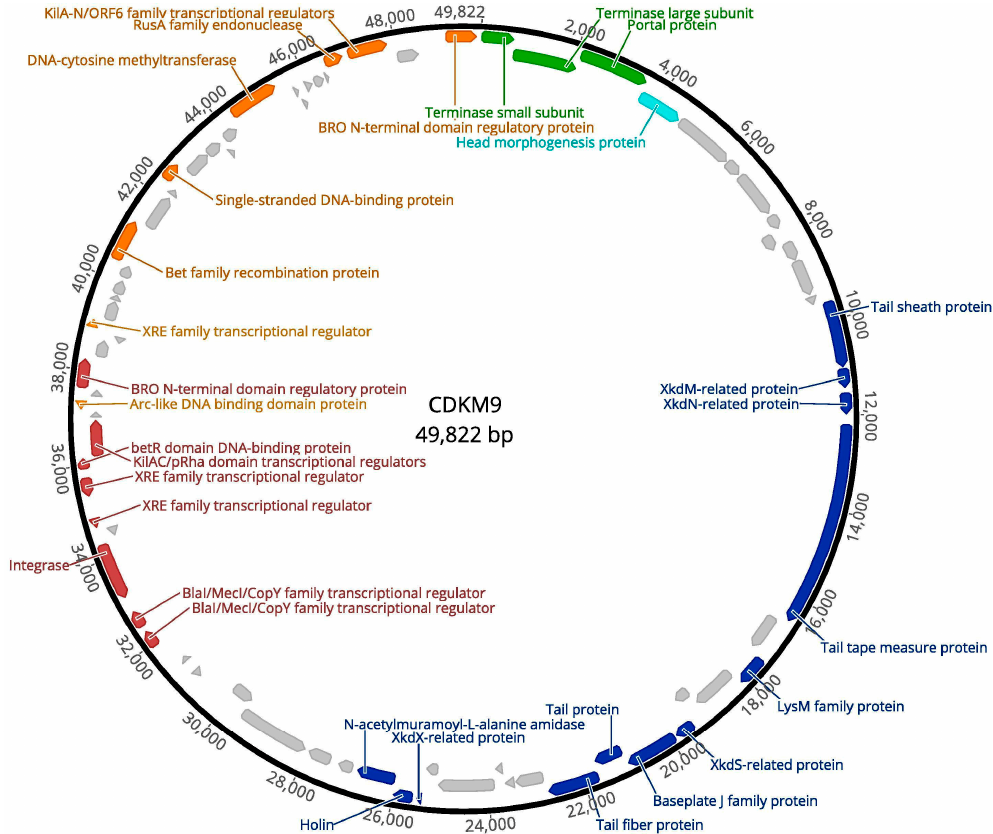
Figure 4. Genome organisation of CDKM9. The 49,822 bp genome assembled as a circle, shown here oriented to start at the terminase small subunit gene. The predicted CDSs are marked with arrows and colours indicate functional modules: head packaging (green), head (aquamarine), tail and lysis (blue), lysogenic conversion (purple) and DNA replication (orange). CDSs with no function assigned are light grey. Those with functional annotations are labelled.